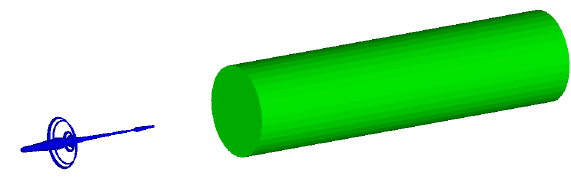
Fig. 3. Numerical model of shaped charge jet and